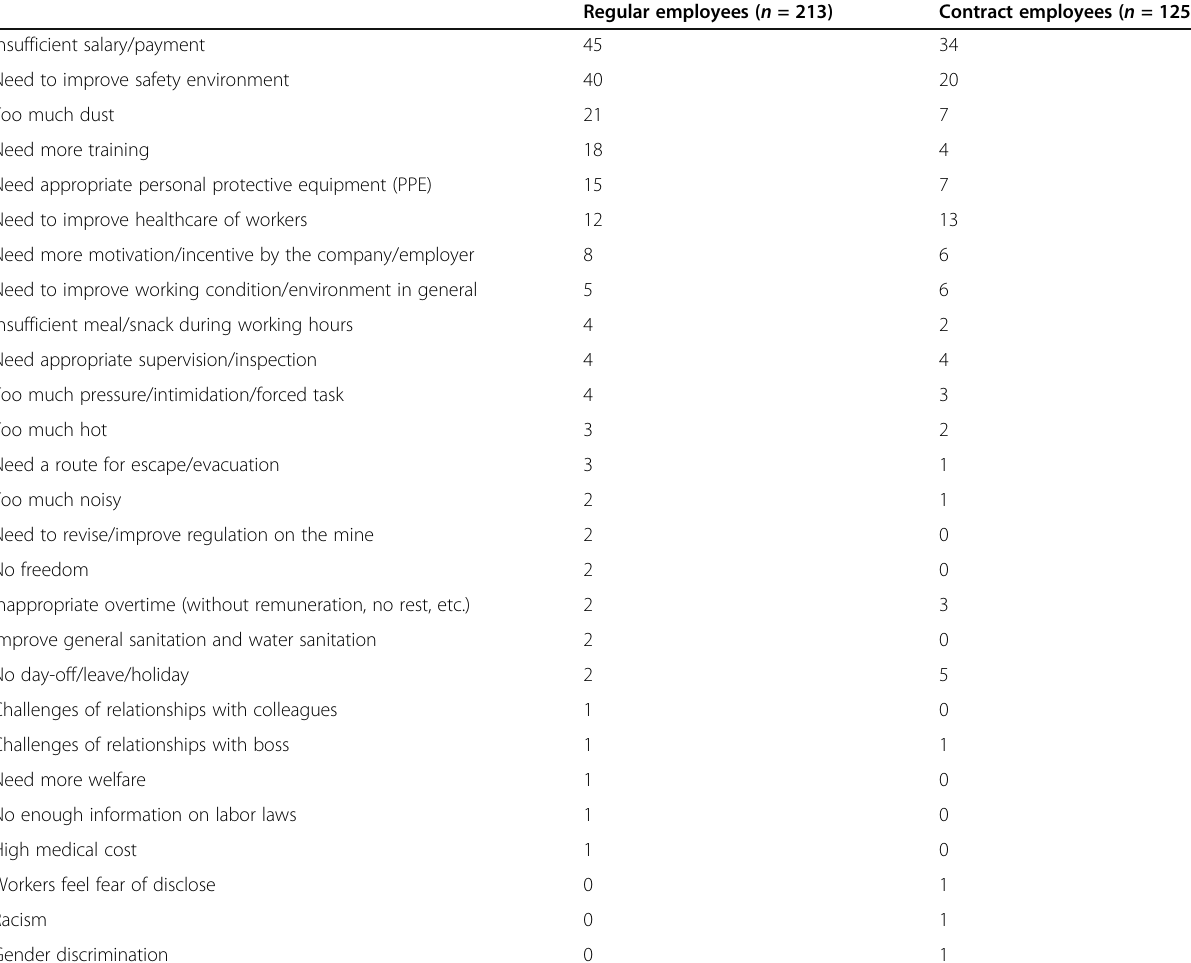
Table 6 Free description regarding working conditions and